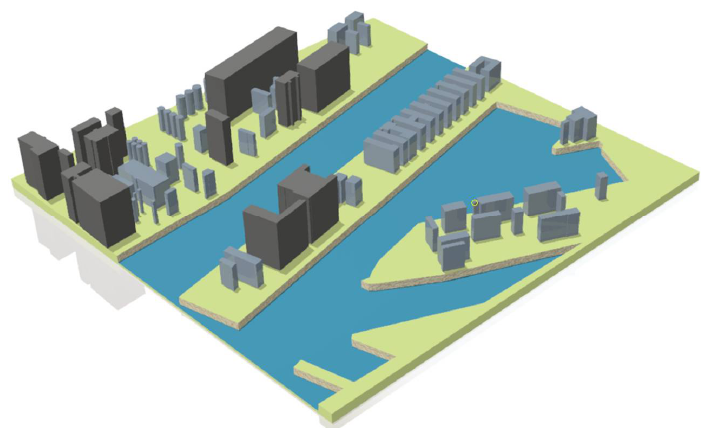
Figure 10. Virtual model of the Kashubian Canal.